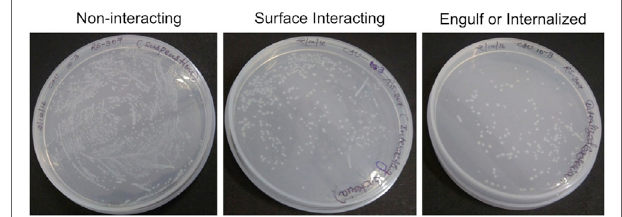
FigUre 1 | Counting of colony-forming unit of non-interacting, surface interacting, and engulf or internalized bacteria cultured on Luria-Bertani Agar at 10 − 3 dilution. The triplicate experiments were performed and result of one experiment is